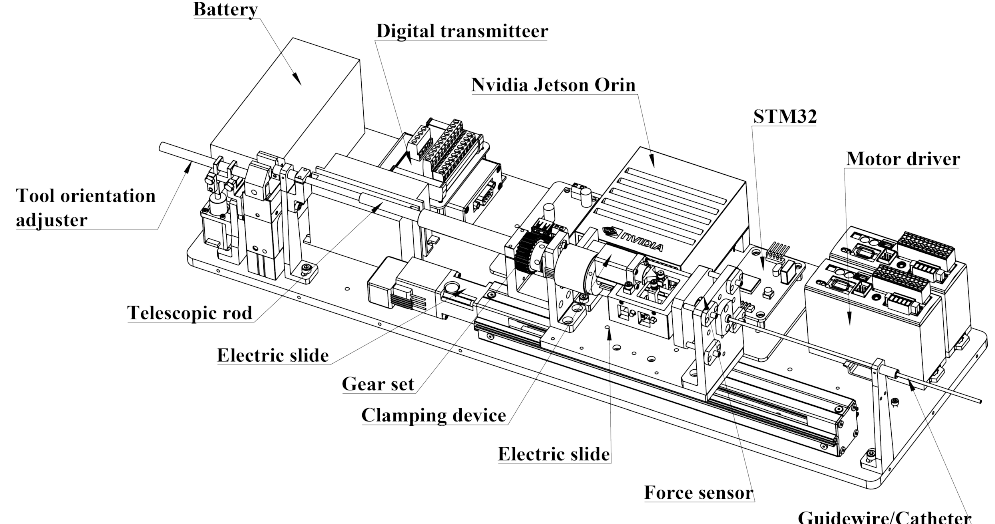
Figure 5. Structure of the patients’ terminal for vascular